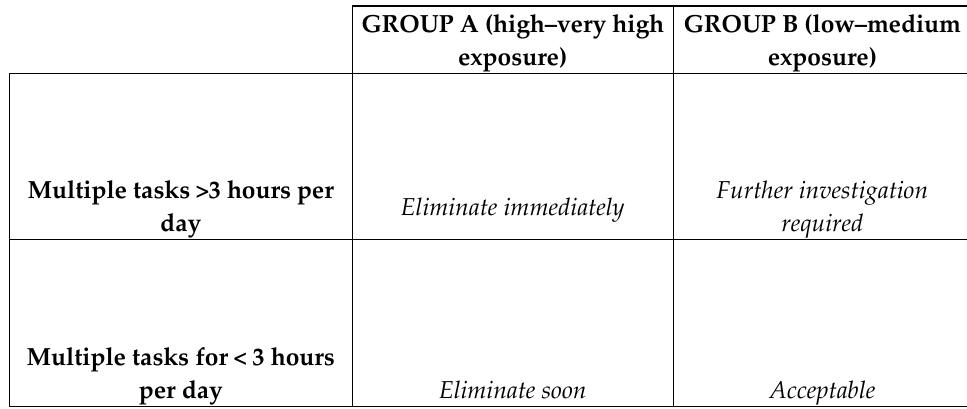
Figure 1. The RULA scoring sheet [10] extended to include duration, vibration and varying daily routines.